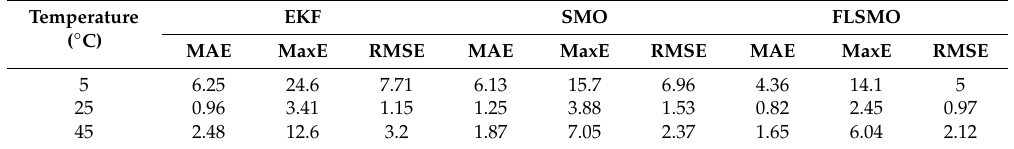
Table 7. SOC estimation error under different temperature.